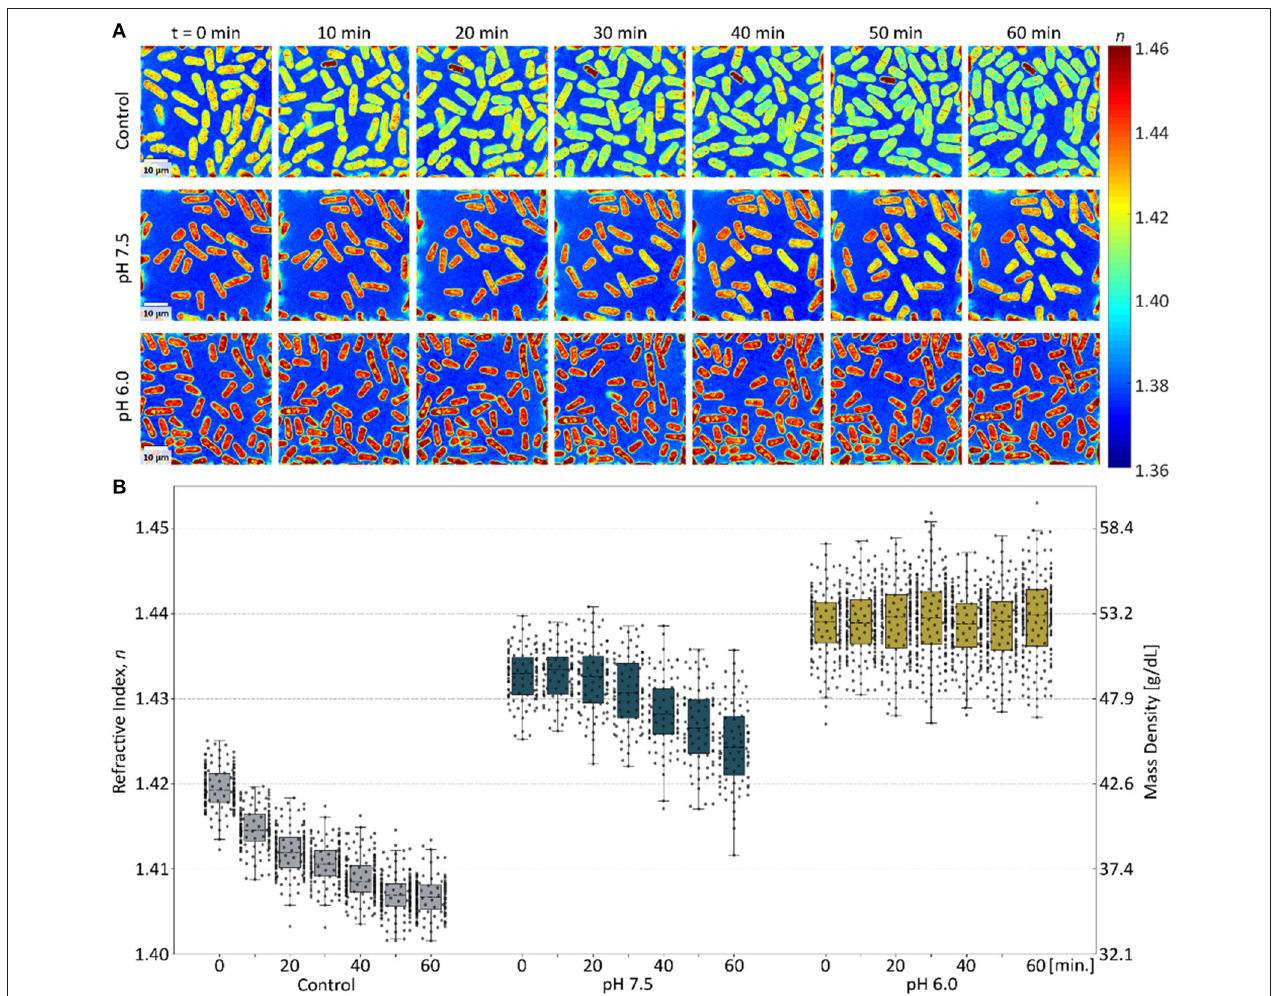
FIGURE 5 | The effect of intracellular pH on the recovery rate of the mass density of yeast cells after osmotic stress. (A) The cross-sectional slices of time-lapse 3D RI tomograms of yeast cells with different intracellular pH, acquired every 10min after osmotic stress. The scale bar indicates 10 µ m. (B) The mean refractive index distribution of osmotically stressed cells in YES medium (gray, N > 120), at pH 7.5 (blue, N > 70) and at pH 6.0 (yellow, N > 150). The box plot indicates the interquartile ranges (IQR) with a line at the median. The whiskers extend to the data within the 1.5 IQR of the respective quartile. Outliers outside of 1.5 IQR are marked as ×